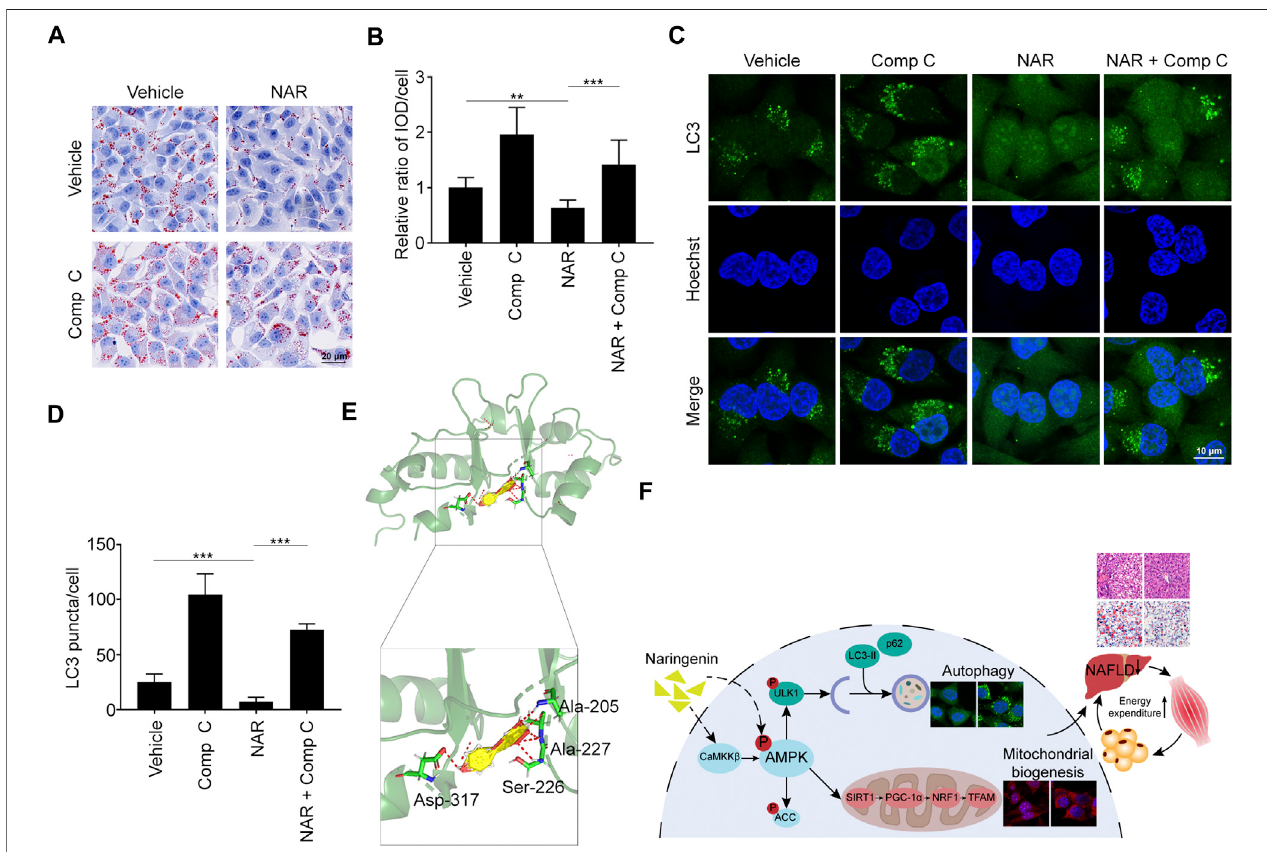
FIGURE 8 | NAR exerts effects by binding to AMPK γ 1. Sodium oleate-induced L02 cells were treated with NAR (6.7 μ M) alone or in combination with Comp C (4 μ M) for 24 h. (A,B) Lipid accumulation was detected using oil red O staining (the objective ampli fi cation 20 × ). (C,D) Endogenous LC3 in L02 cells were detected with immuno fl uorescence (green)(the objective ampli fi cation 63 × ). (E) DockingofNAR at theactivesites ofAMPK γ 1 wasperformed byLeDock software. The red dottedline indicatedahydrogenbond. (F) Theschematicdiagramofourstudy.Barsrepresent20 μ M (A) ,10 μ M (C) .Allvalueswereexpressedasthemean ± SDfromthreeor more independent experiments. *** p < 0.001; ** p < 0.01; * p < 0.05 vs. untreated cells or as indicated. Abbreviation: NAR, naringenin; Comp C, Compound C; IOD, integrated optical density; Ala, Alanine; Ser, Serine; Asp, Aspartic acid; ACC, acetyl-CoA carboxylase 1; AMPK, AMP-activated protein kinase; CaMKK β , calmodulin- dependent protein kinase β ; LC3, microtubule-associated protein 1A/1B-light chain 3; NRF1, nuclear respiratory factor 1; PGC-1 α , peroxisome proliferator-activated receptor coactivator 1 α ; p62, ubiquitin-binding protein p62; SIRT1, NAD-dependent protein deacetylase sirtuin-1; TFAM, mitochondrial transcription factor A; ULK1, Unc-51 like autophagy activating kinase